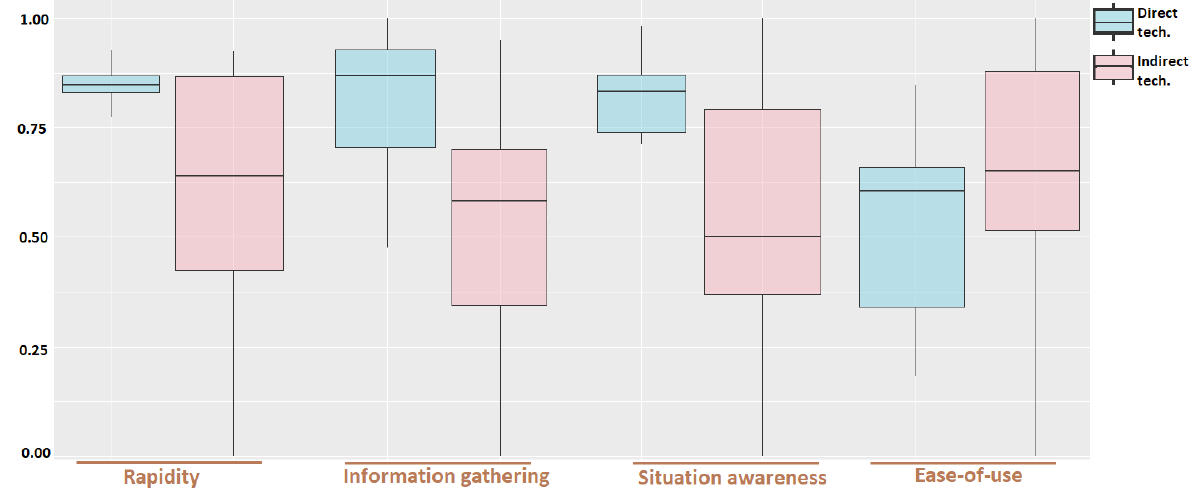
Figure 9. Quality factors scores distribution—between desktop subjects data.